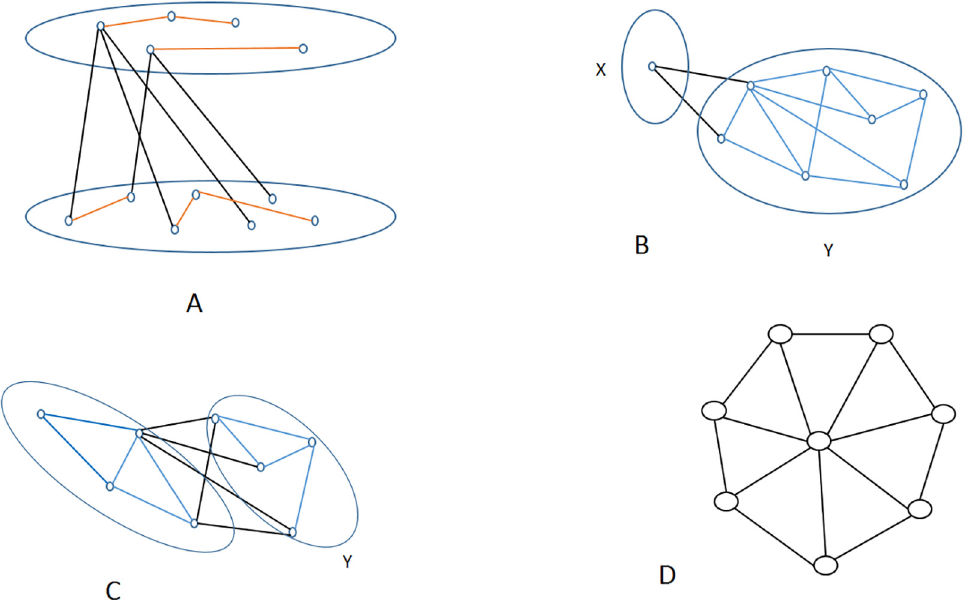
Fig 1. Panel A: An X-Y cut. The cut-edges are colored black. Panel B: An un-balanced minimum cut. Panel C: A balanced cut. Panel D: The wheel